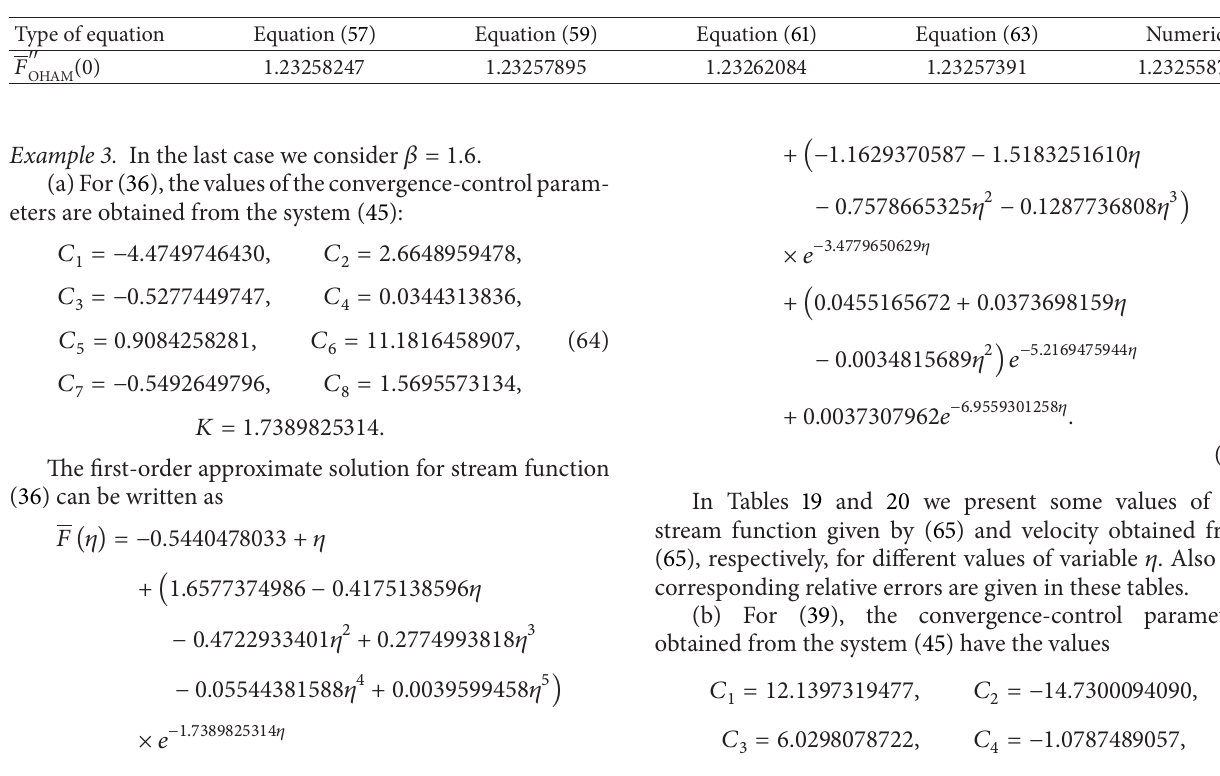
󸀠󸀠 (0) obtained by means of OHAM and numerical results for 𝛽 = 1 .